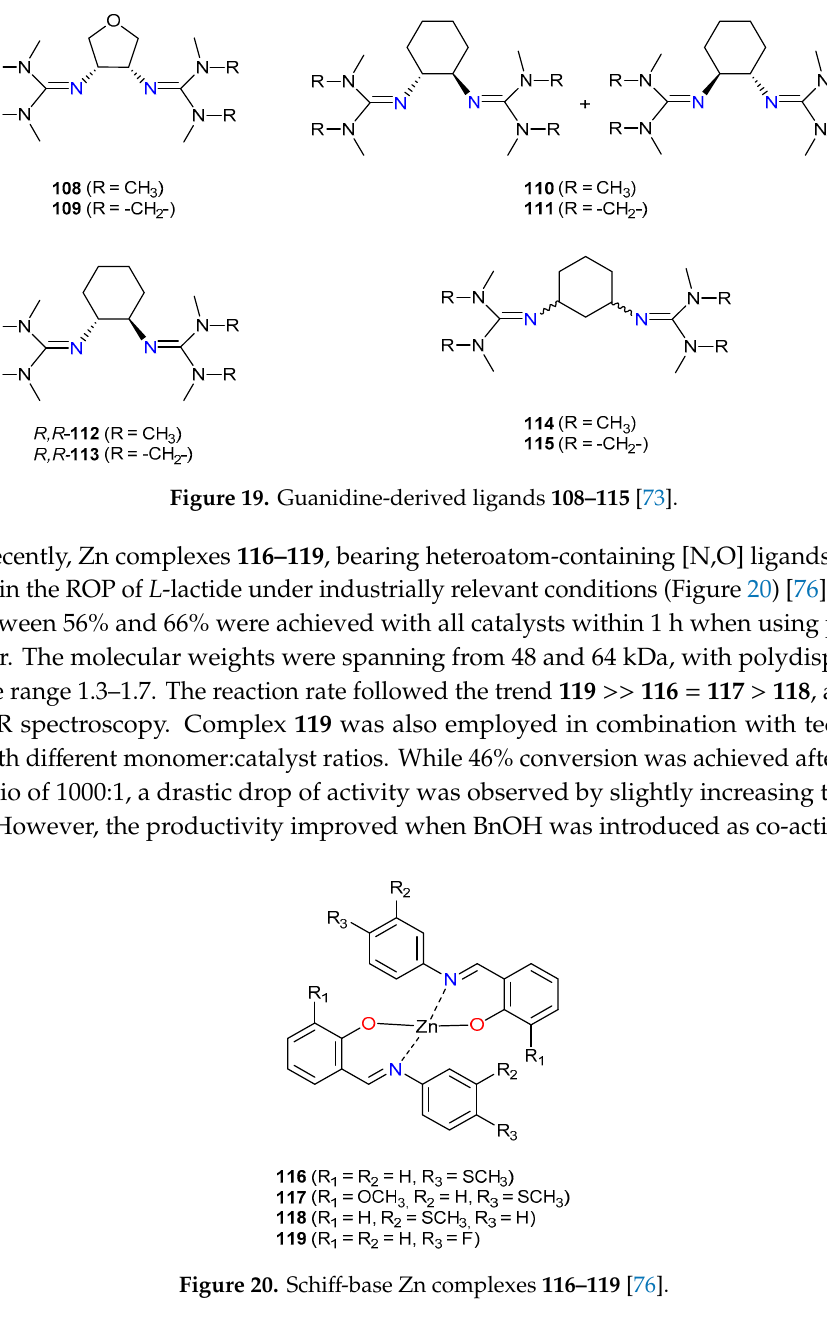
Figure 19. Guanidine-derived ligands 108–115 [73].